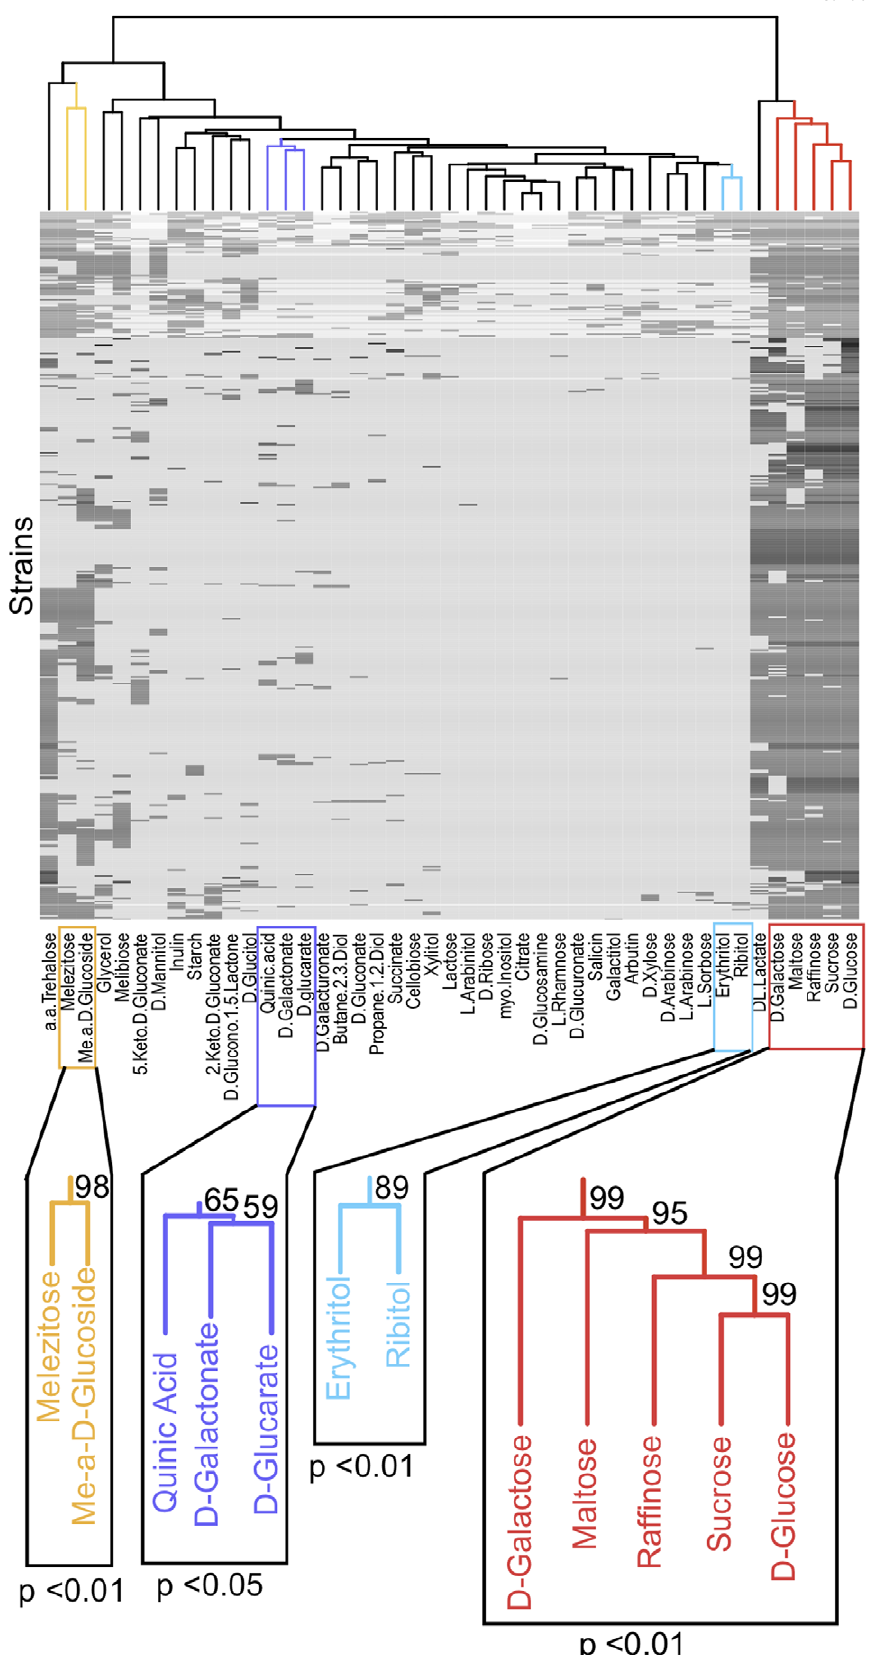
Figure 3. Nonrandom distribution of four clusters of carbon source utilization traits across strains. The heat map shows the ability (black cells) or inability (grey cells) of each strain to utilize each carbon source. Missing data is indicated by white cells. Callout boxes indicate significant clusters of carbon sources according to multiscale bootstrap resampling. P-values and bootstrap support are provided for the significant clusters. doi:10.1371/journal.pone.0054403.g003 PLOS ONE |